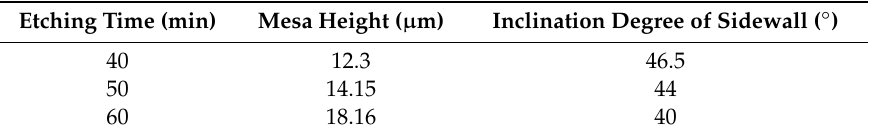
Table 1. Shape parameters of the circular mesas etched in Tetramethylammonium hydroxide (TMAH) + Triton-X-100 solution after di ff erent